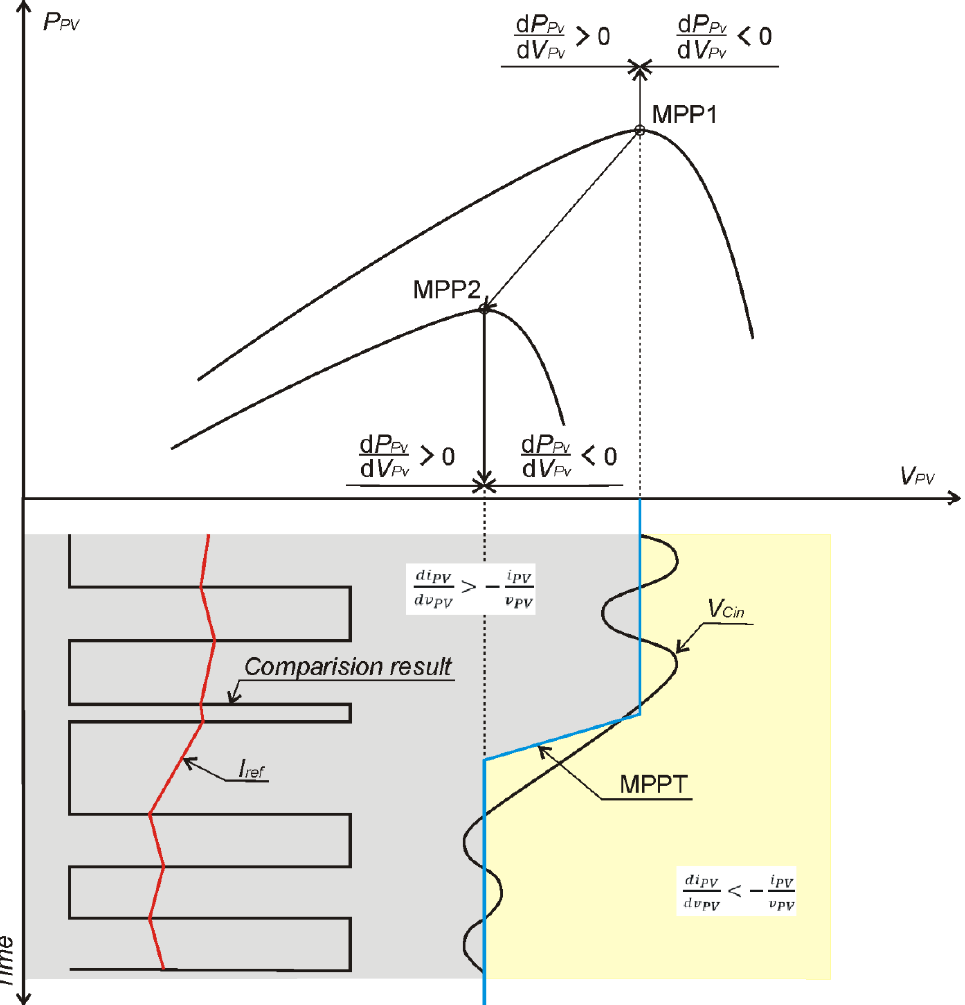
Figure 2. Graphical interpretation of the reference current generation by the MPPT for a one-phase system under voltage ripples and external condition changes .